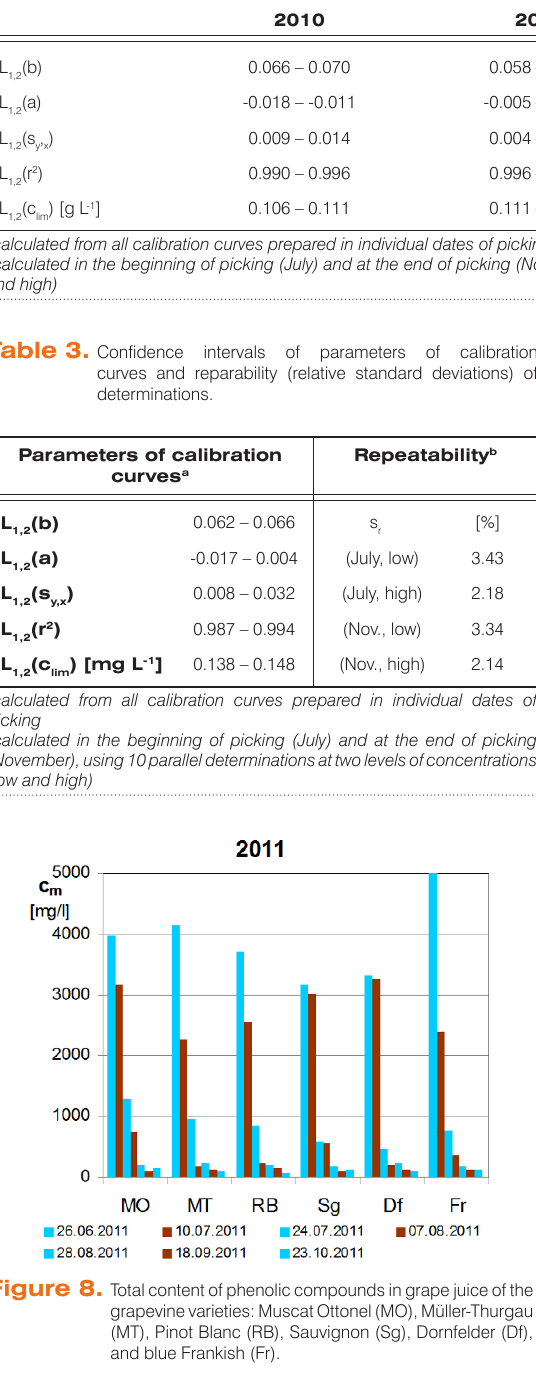
Table 2. Confidence intervals of parameters of calibration curves and repeatability (relative standard deviations) of determinations. Parameters of calibration curves a